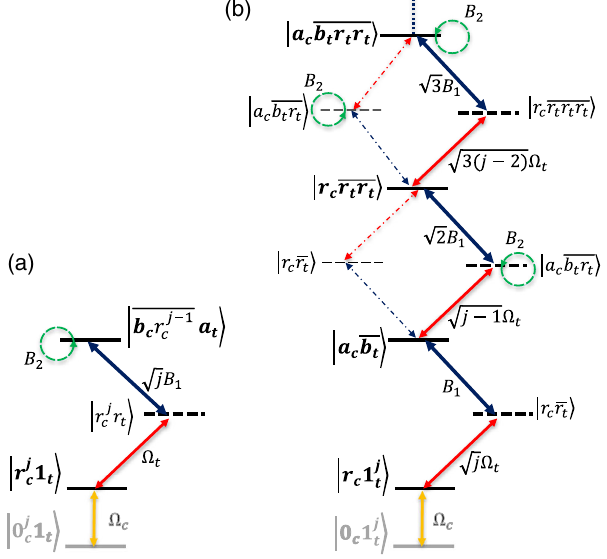
FIG. 2. Dark states in (a) Toffoli and (b) fan-out gates. Only the state components shown in bold face get populated. In the fan-out gate (b), the system undergoes up to j STIRAP transfer processes. The collective states ’ notation, indicated by the overline, is defined in the